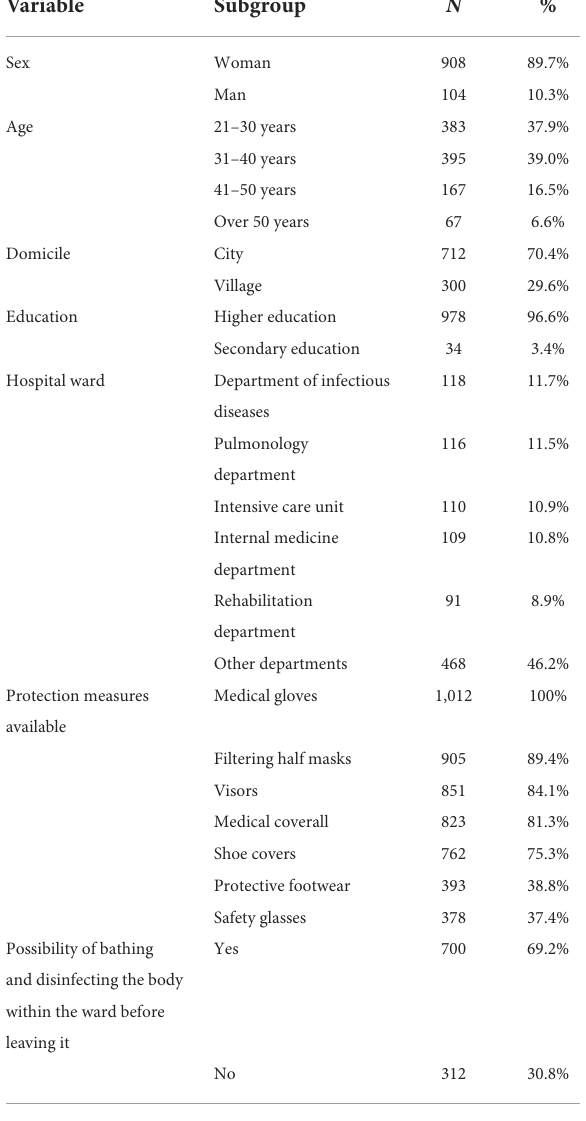
TABLE 1 Sociodemographic